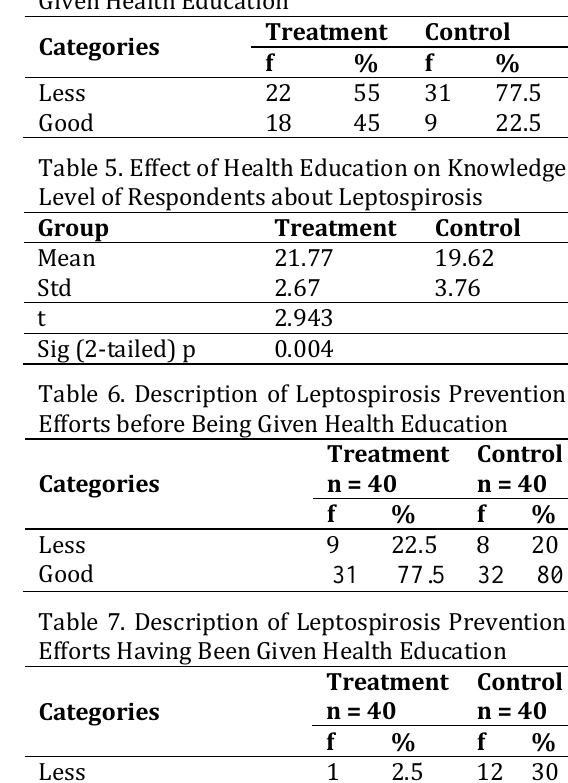
Table 4. Description of Knowledge Level of